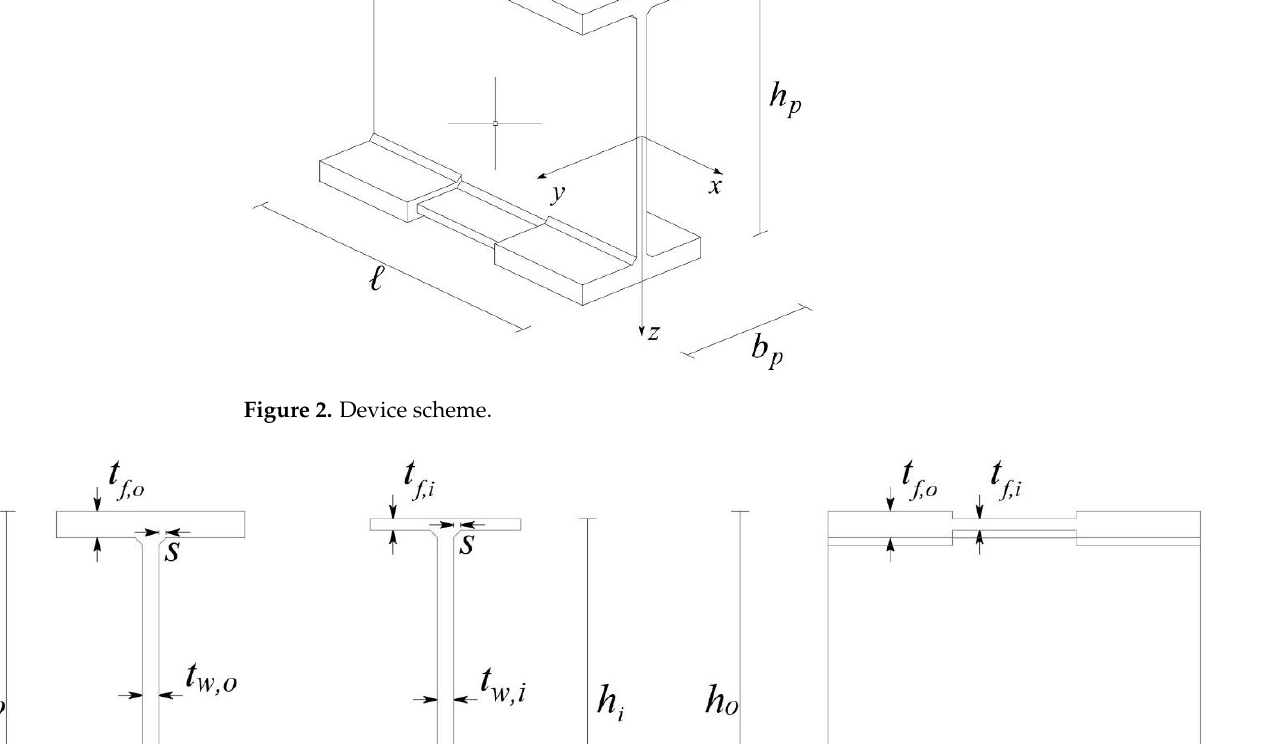
Figure 2. Device scheme.